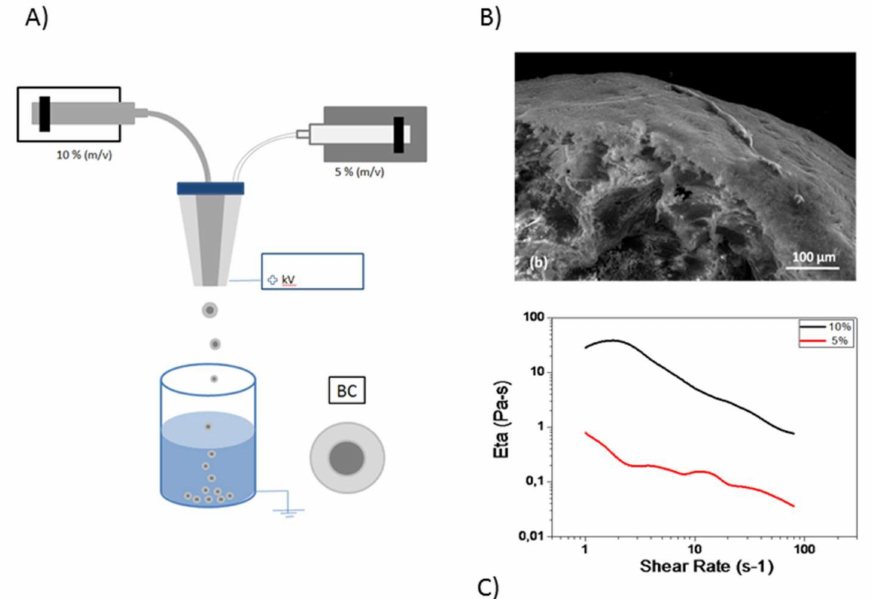
Figure 4. BC capsules: ( A ) scheme of preparation; ( B ) cross-section image via LV-SEM; ( C ) viscosity vs. shear rate in the case of inner (black) and outer (red) CA solutions.